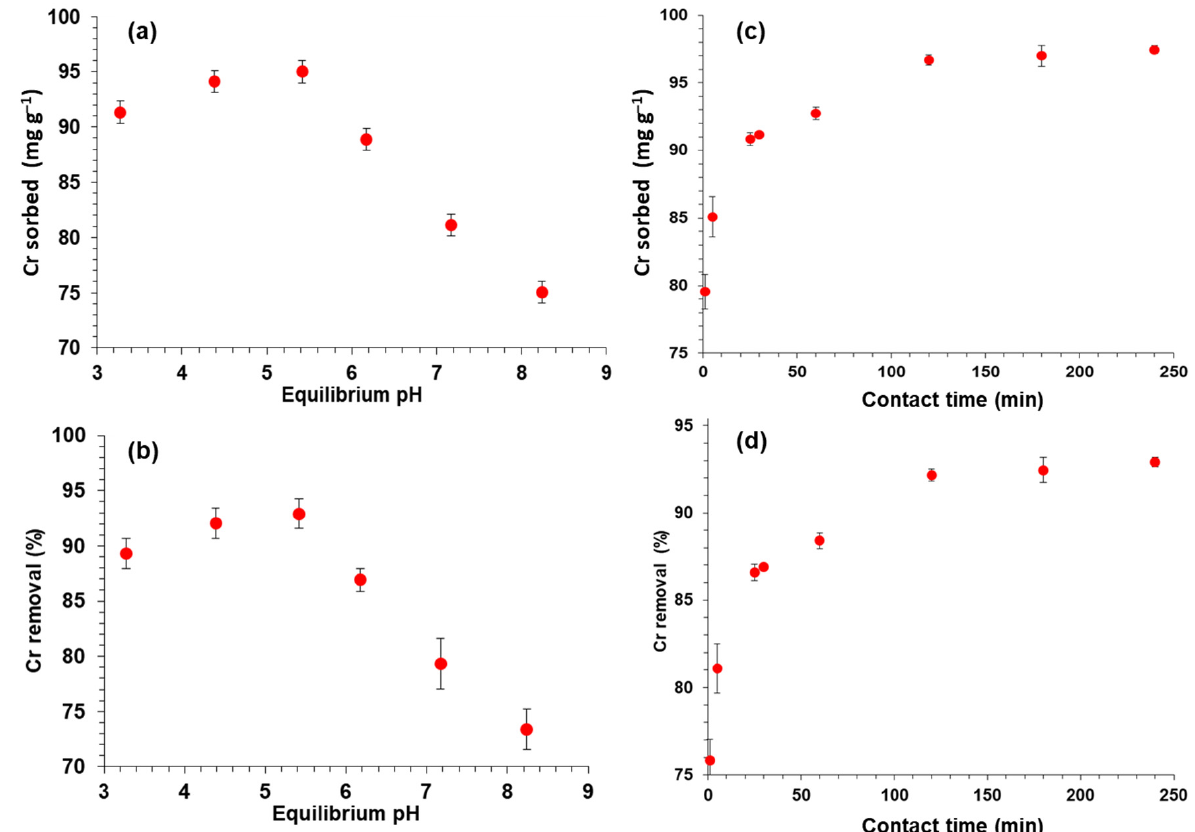
Figure 1. Adsorption of chromium on WSB: ( a , b ) pH effect and ( c , d ) contact time 1. Figure 1 图片